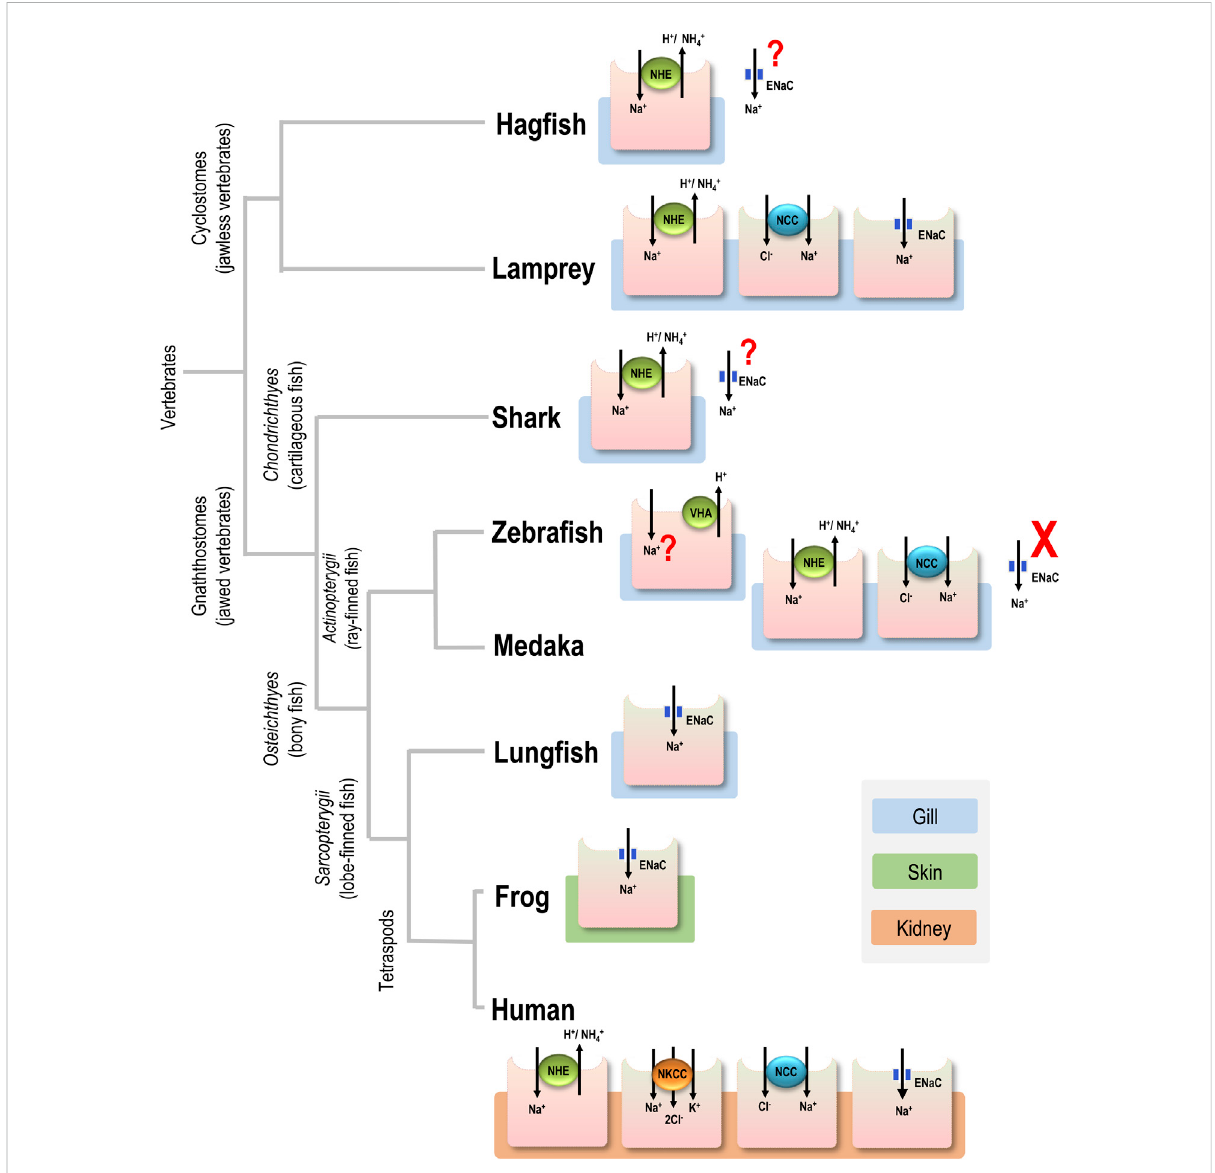
FIGURE 1 Major apical ion transporters for Na + uptake in various vertebrates. For simplicity, only transporters in the gills of aquatic vertebrates, the skin of frog, and the kidney of human are shown. Ionocytes are responsible for Na + uptake function. ENaC, epithelial Na + channel; NCC, Na + -Cl - cotransporter; NHE, Na + /H + exchanger; NKCC, Na + -K + -2Cl - cotransporter; question mark (?), transport pathway without physiological or cell biological characterization; cross mark (X), loss of the